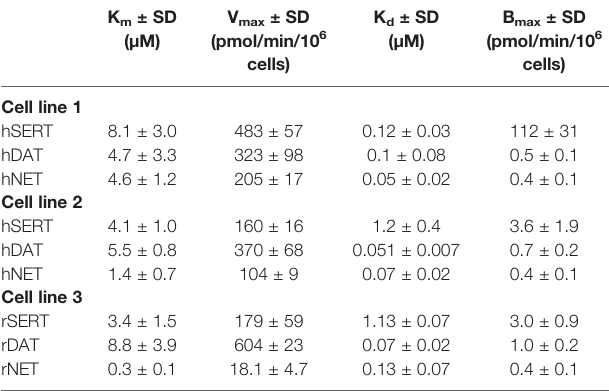
TABLE 4 | Kinetic parameters for the uptake and binding of radioligands in adherent transporter-transfected HEK 293 cells. K m ± SD V max ± SD (µM) (pmol/min/10